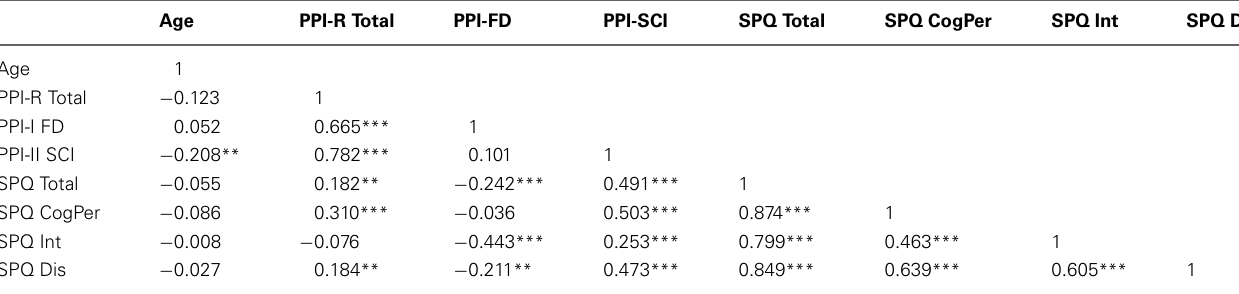
Table 2 | The relationships between the PPI-R and SPQ total and factor